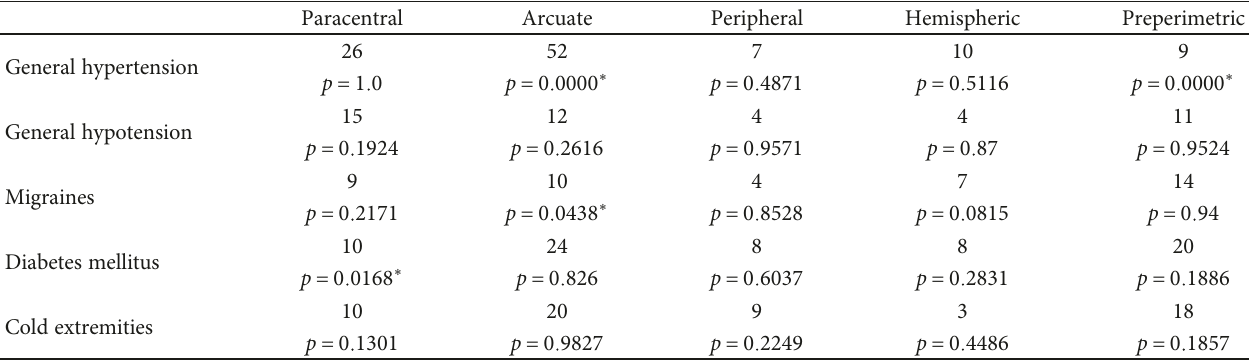
Table 3: General risk factors in studied subgroups. In the table, a number of eyes were shown; a chi-square test compared if the speci fi c risk factor is more/less frequent in the group with speci fi c morphology of scotoma comparing to that in the rest of the studied